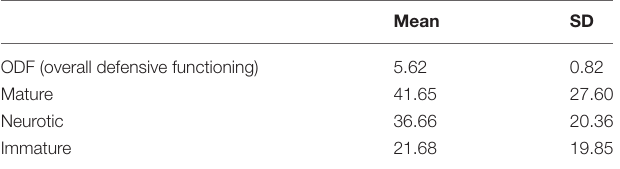
TABLE 3 | Overall defensive functioning and defense